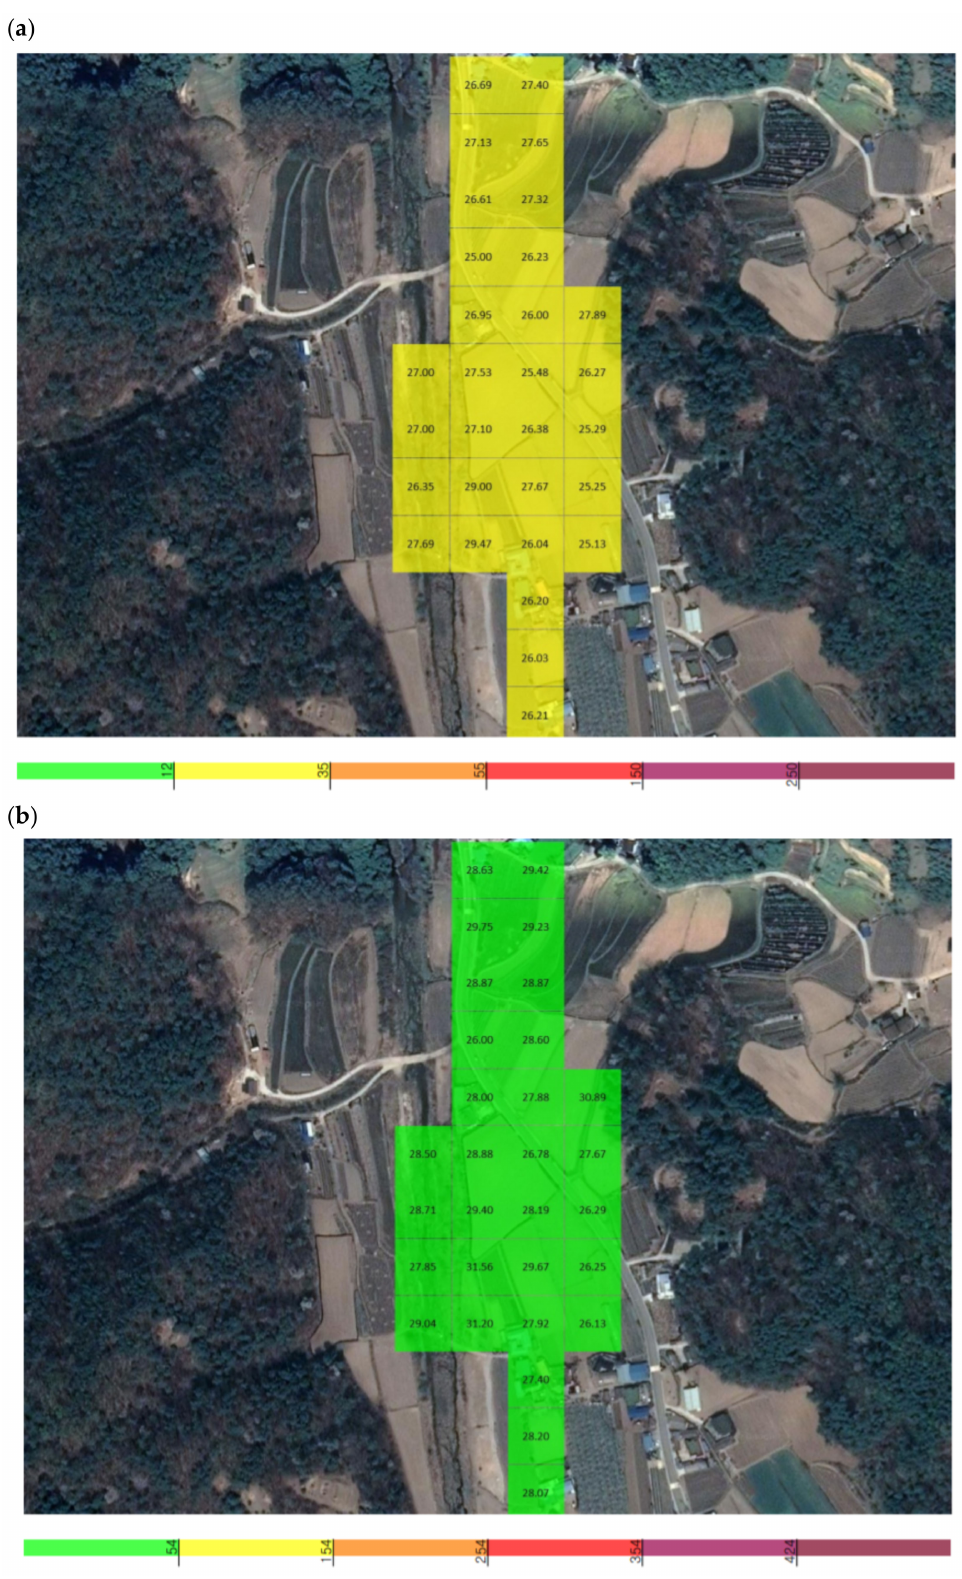
Figure 6. Grid detection area of the UAV measuring sensor in the area nearby X quarry: ( a ) PM 2.5